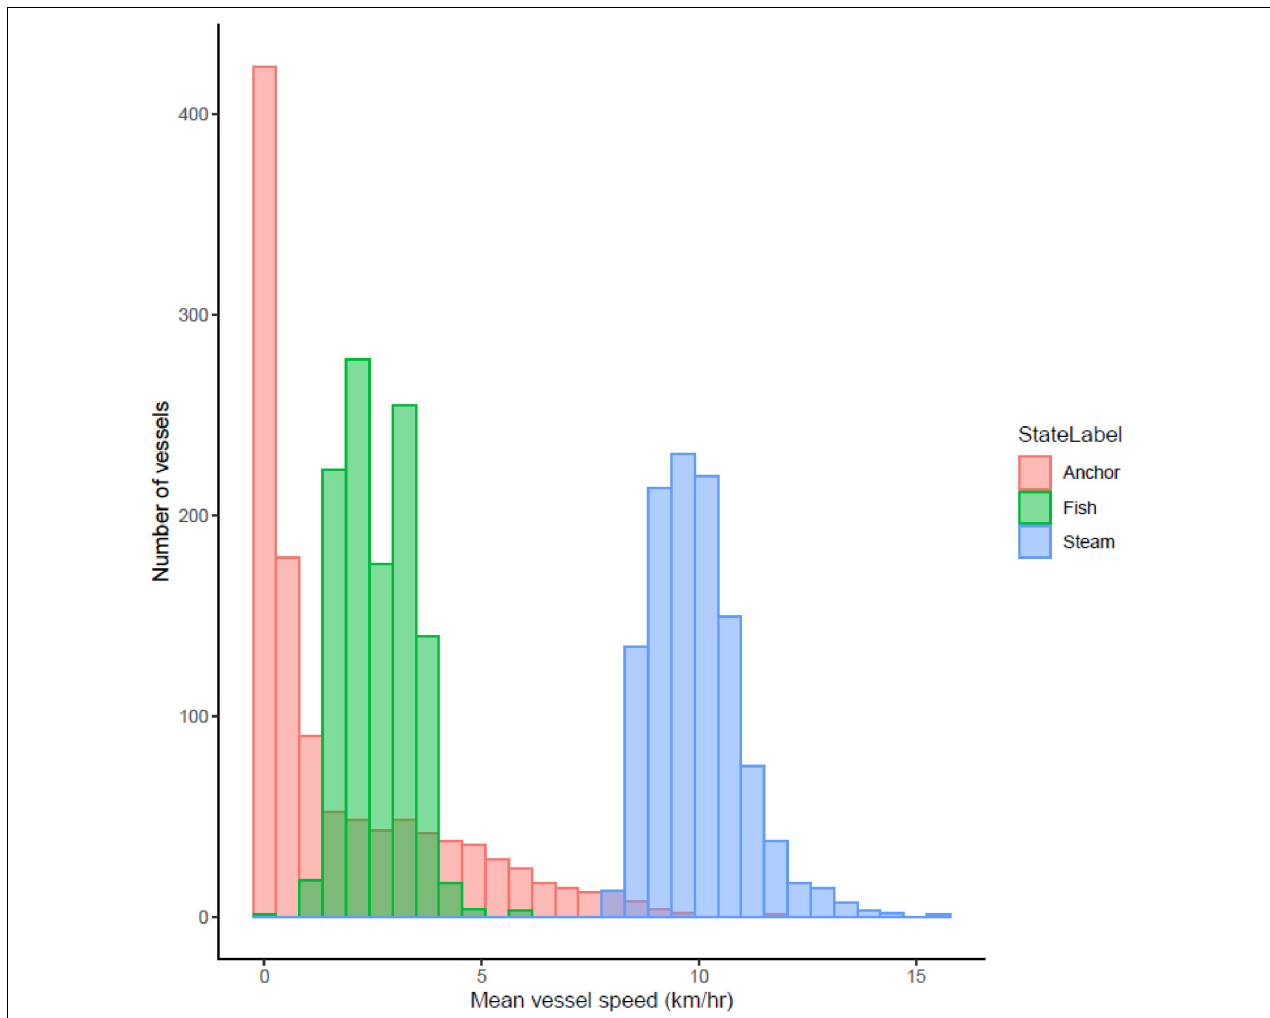
FIGURE 4 | Average speed for each vessel associated with each behavioral state. The speeds are taken from all 1,082 vessels whose behavior was classified, with the average calculated for each vessel across all of its VMS